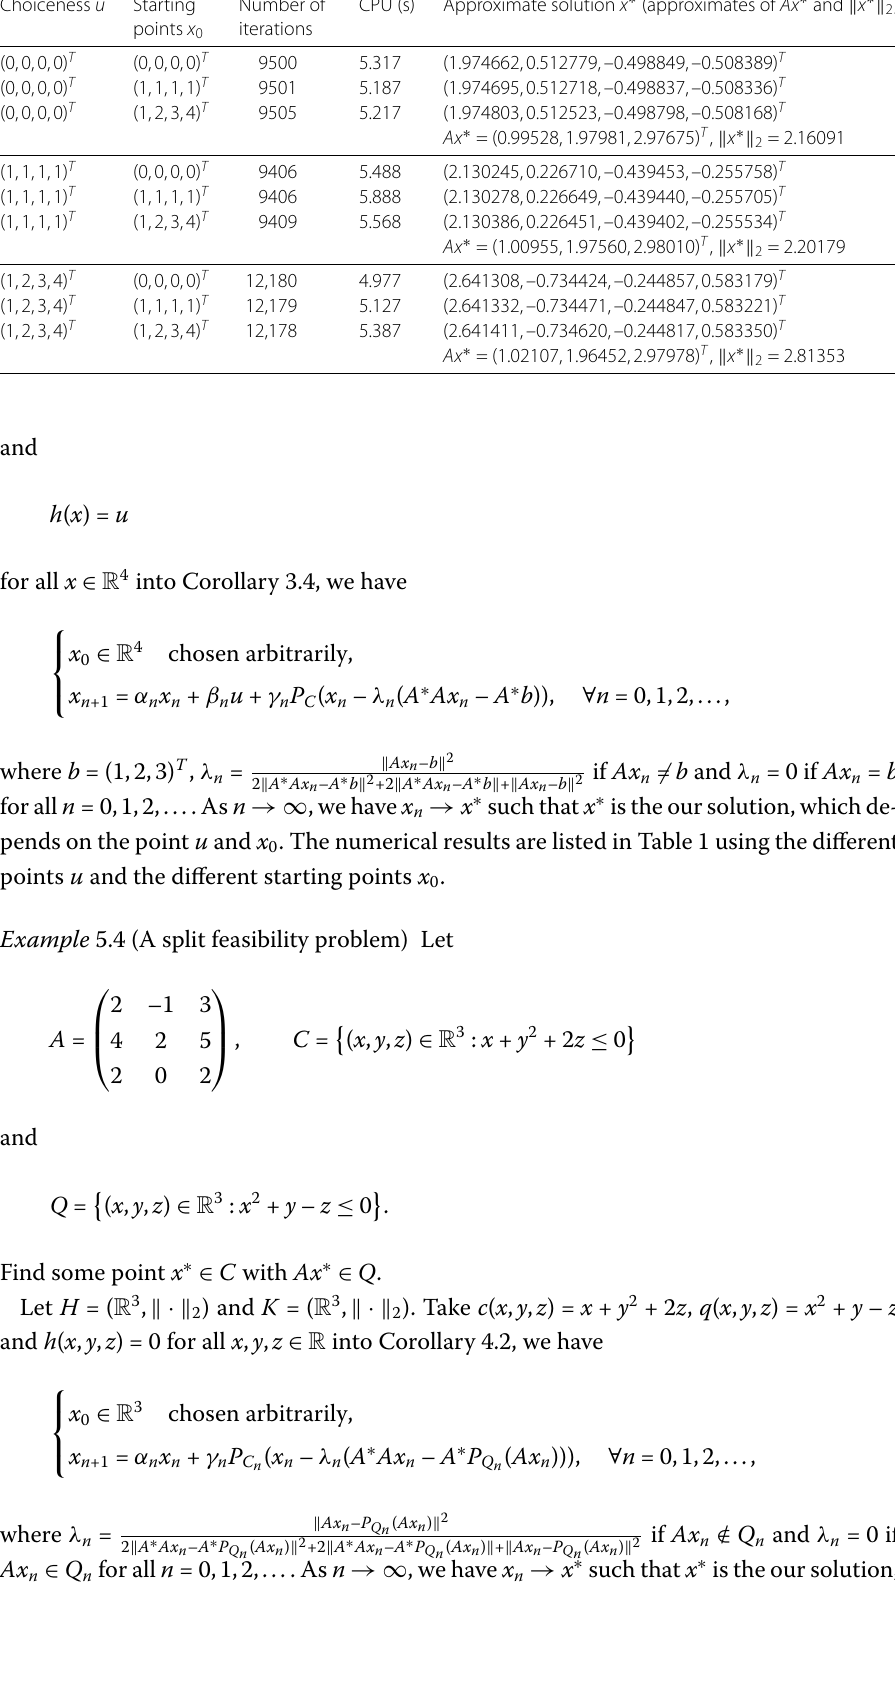
Table 1 Results for Example 5.3 using the algorithm in Corollary 3.4 Choiceness u Starting Number of CPU (s) Approximate solution x ∗ (approximates of Ax ∗ and (cid:4) x ∗ (cid:4) 2 points x 0 iterations